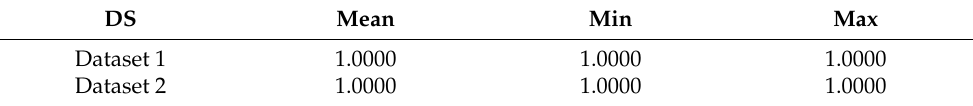
Table 2. The min, max, and mean of NMI of the proposed method on two datasets. DS Mean Min Max Dataset 1 1.0000 1.0000 1.0000 Dataset 2 1.0000 1.0000